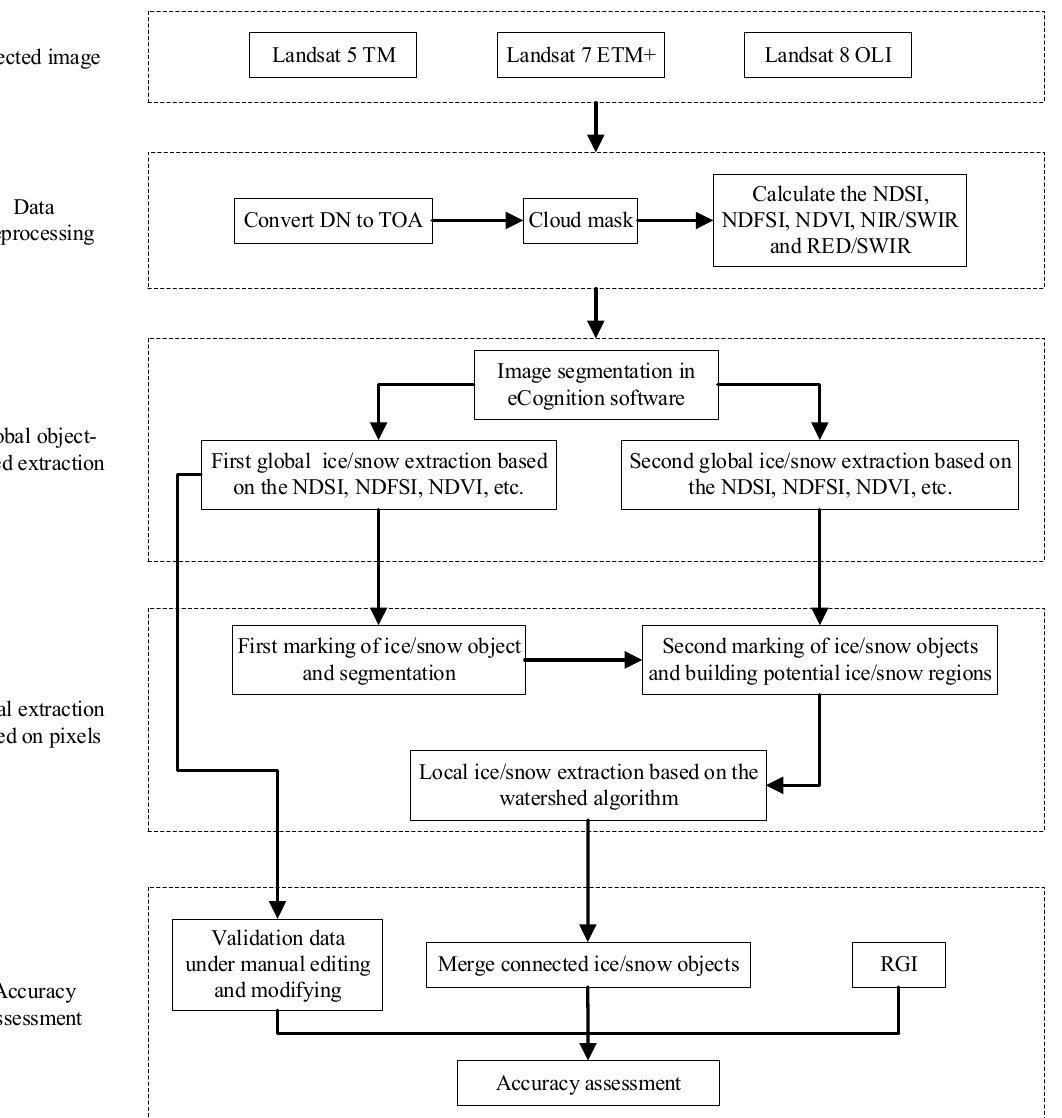
Figure 2. The workflow for extracting surface ice/snow based on the objects and pixels. DN: digital number; TOA: top of atmosphere; NDSI: normalized difference snow index; NDFSI: normalized difference forest snow index; NDVI: normalized difference vegetation index; RGI: Randolph Glacier Inventory.